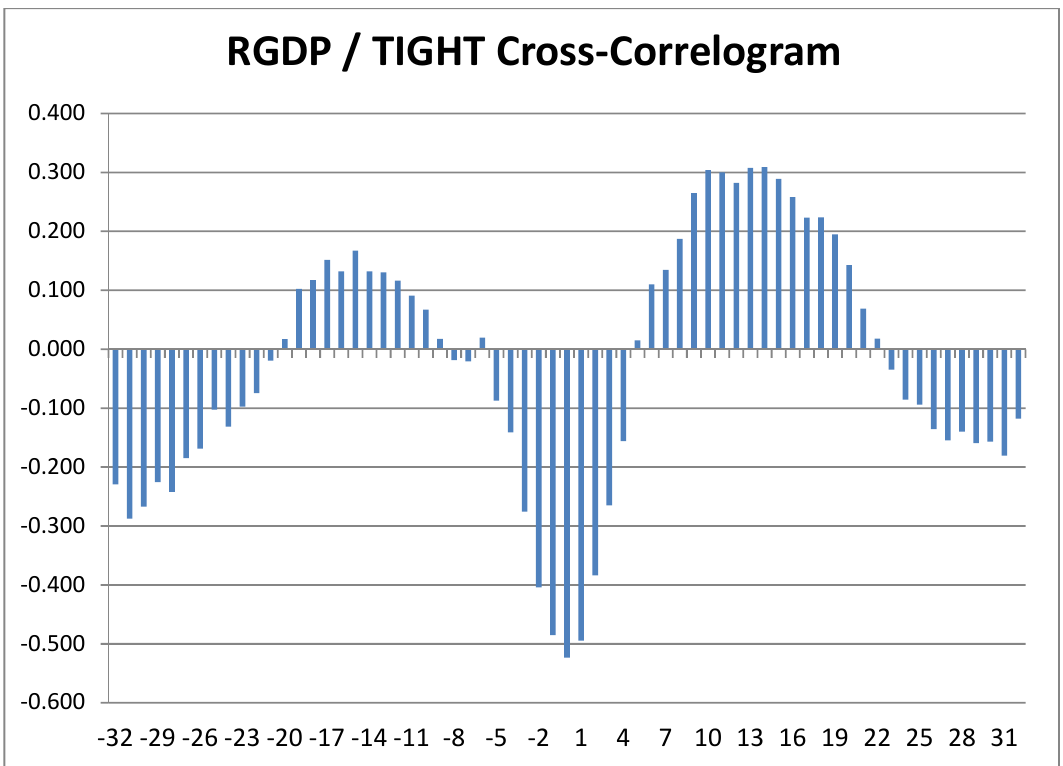
Figure 3. Cross-Correlogram with lags and leads on the x-axis. See Figure 1 caption for sample details.